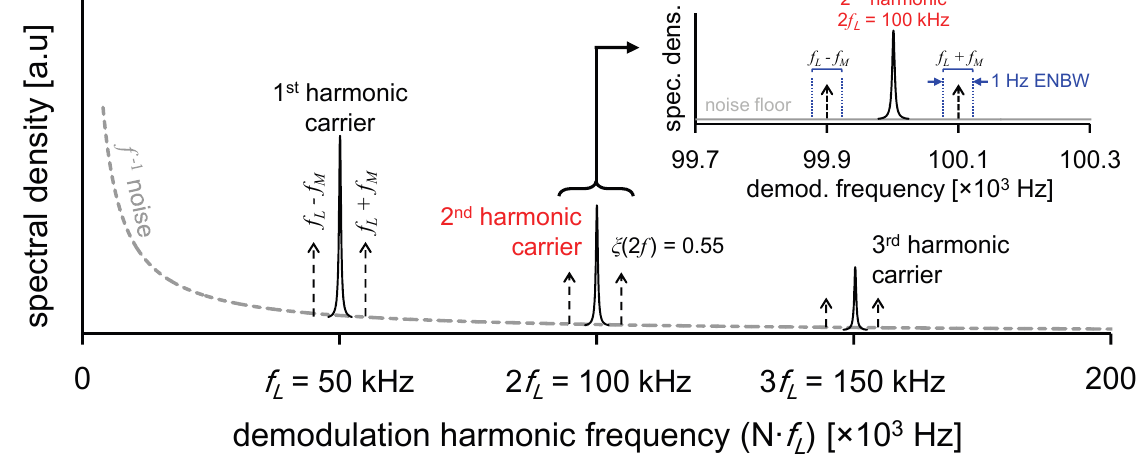
Figure 1. Spectral schematic of DM-FRS signal frequencies. Modulation of the laser occurs at f L = 50 kHz, resulting in wavelength modulated carrier frequencies at N · f L and a corresponding decrease in 1/ f noise. Further modulation of the magnetic field ( f M = 100 Hz) results in generation of sum and difference frequency sidebands N · f L ± f M (scales in schematic are exaggerated for clarity). In DM-FRS, the demodulation bandwidth Δ f must be considered around each sideband, resulting in 2· Δ f total noise